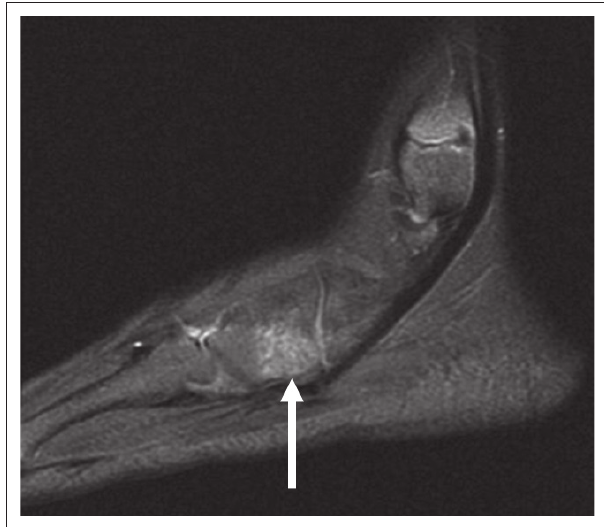
FIGURE 2: Cuboid contusion. Sagittal fast spin echo T2-weighted image (Repetition Time [TR]/Echo Time [TE] 3500/73 ms) of the lateral aspect of the foot shows focal oedema-like signal within the cuboid. No fracture line was evident. The finding presumably accounted for the patient’s lateral foot pain at presentation.